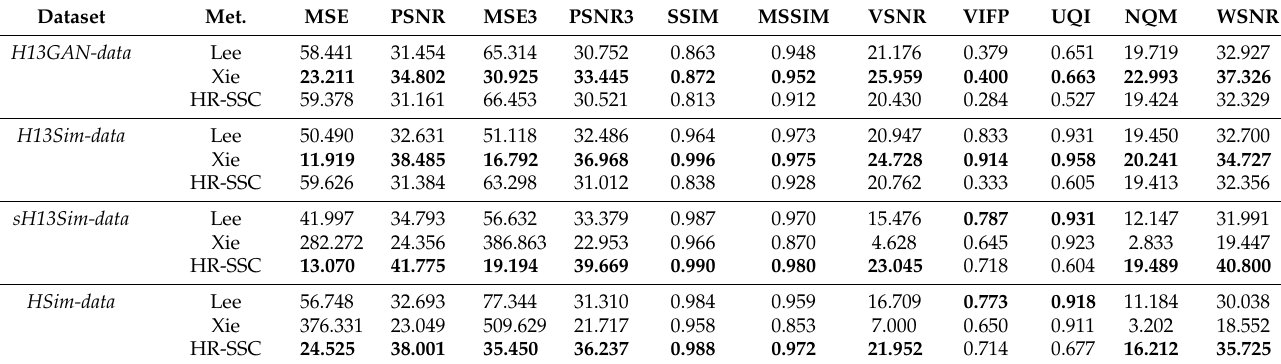
Figure 15. Resulting masks of methods Lee, Xie, and HR-SSC on sH-data .